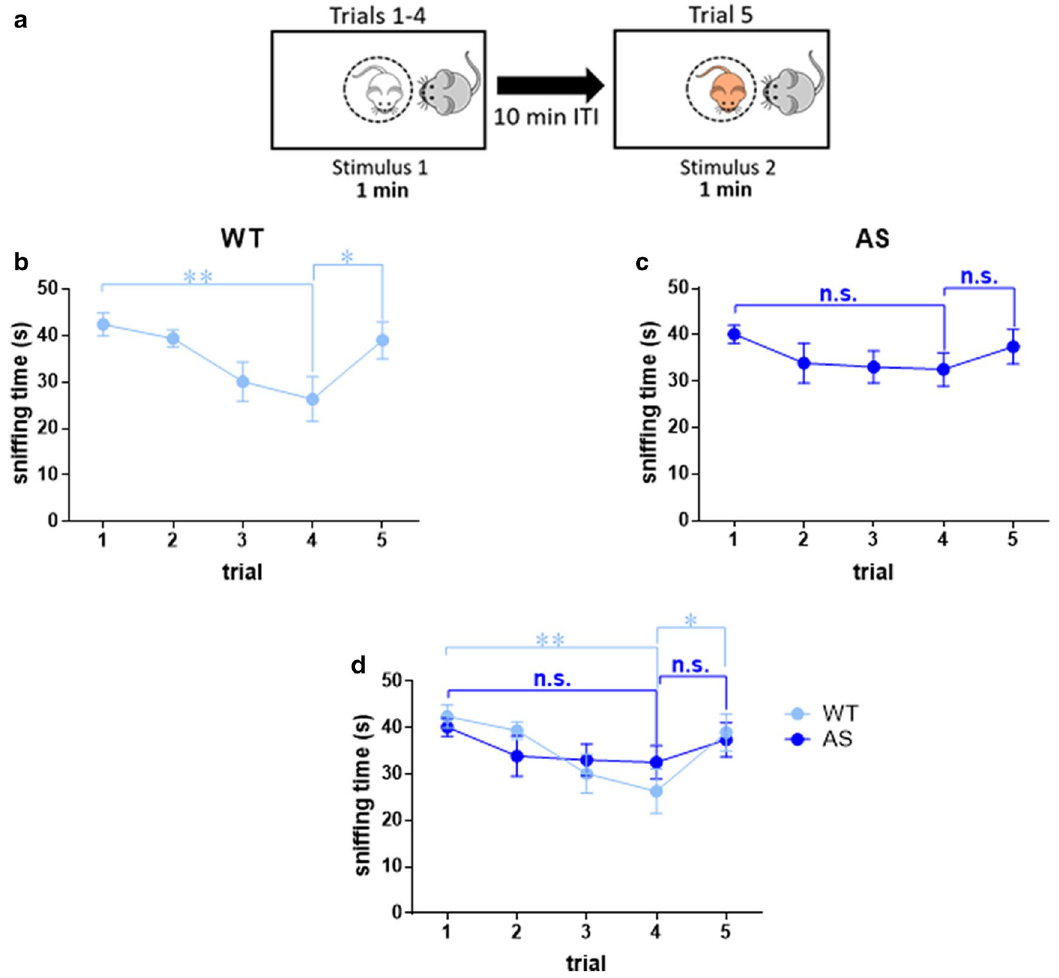
Figure 3. AS male mice exhibit impaired social habituation in social habituation\dishabituation test. ( a ) Illustration of social habituation/dishabituation test. ( b – d ) Social exploration time in each of the five trials. ( b ) Sniffing time of stimulus mouse by WT mouse. WT mice show habituation to the repeatedly introduced stimulus mouse, and dishabituation towards the novel stimulus mouse. ( c ) Sniffing time of stimulus mouse by AS mouse. AS mice do not show habituation to the repeatedly introduced stimulus mouse, nor dishabituation to the novel stimulus mouse. ( d ) Concatenated graph of graphs a and b . Line graphs represent mean ± SEM. N = 12 mice per each group (WT and AS). * p < 0.05, ** p < 0.01 and n.s. = non-significant represent differences between trials within